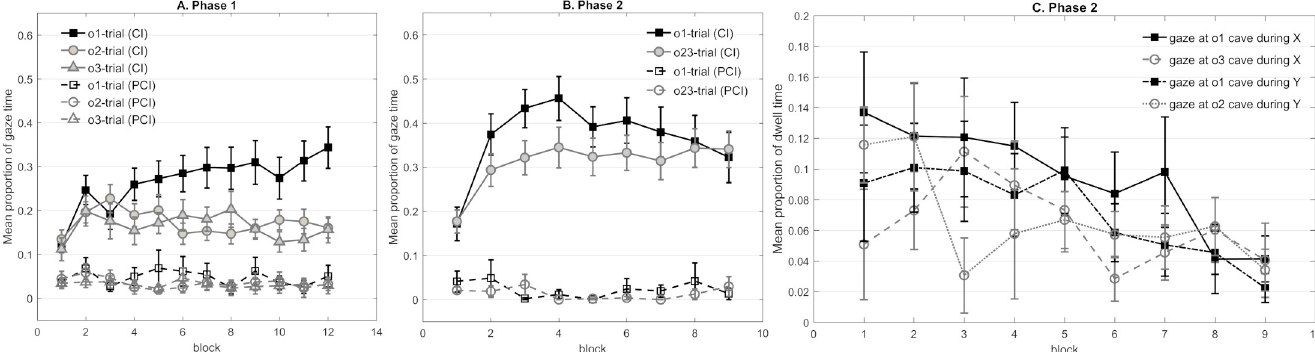
Fig 2. . Panel A and B represent the mean proportion of gaze time in Experiment 1 that participants looked at the correct outcome’s cave during the cue (CI) and the pre-cue interval (PCI) respectively in each phase (A) Mean gaze time across the 12 blocks in Phase 1. (B) Mean gaze time across the nine blocks in Phase 2. Note that gaze time in Phase 2 was averaged based on the predictability of each trial’s outcome in Phase 1. Panel C represents the mean dwell time (i.e. differences in gaze time during the cue and the pre-cue interval) towards the outcome areas during the cues that had not signaled them across nine blocks in Phase 2 (i.e. looking at the o1 cave when Cue X and Y present, looking at o3 cave when X present and at the o2 cave when Y present).